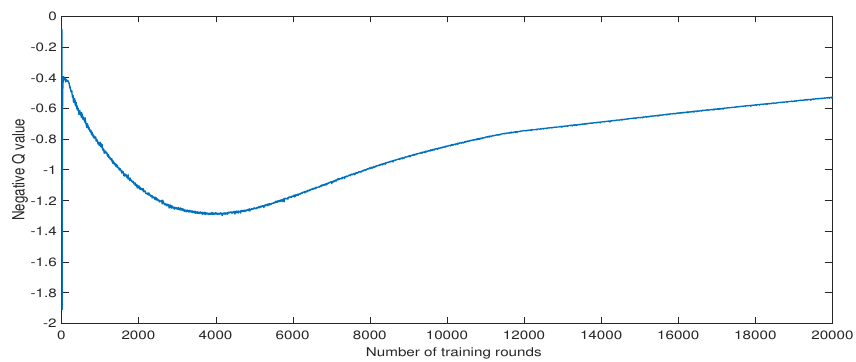
Figure 17. Negative Q value variation curve.